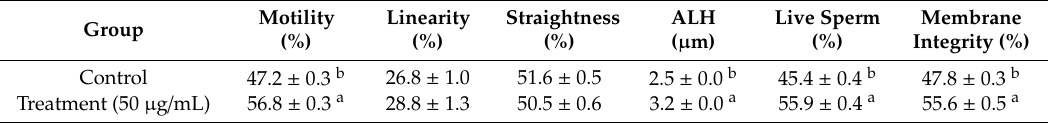
Table 3. E ff ects of exosomal protein treatment on the post-thaw motility, kinematic parameters, viability, and membrane integrity of dog semen.